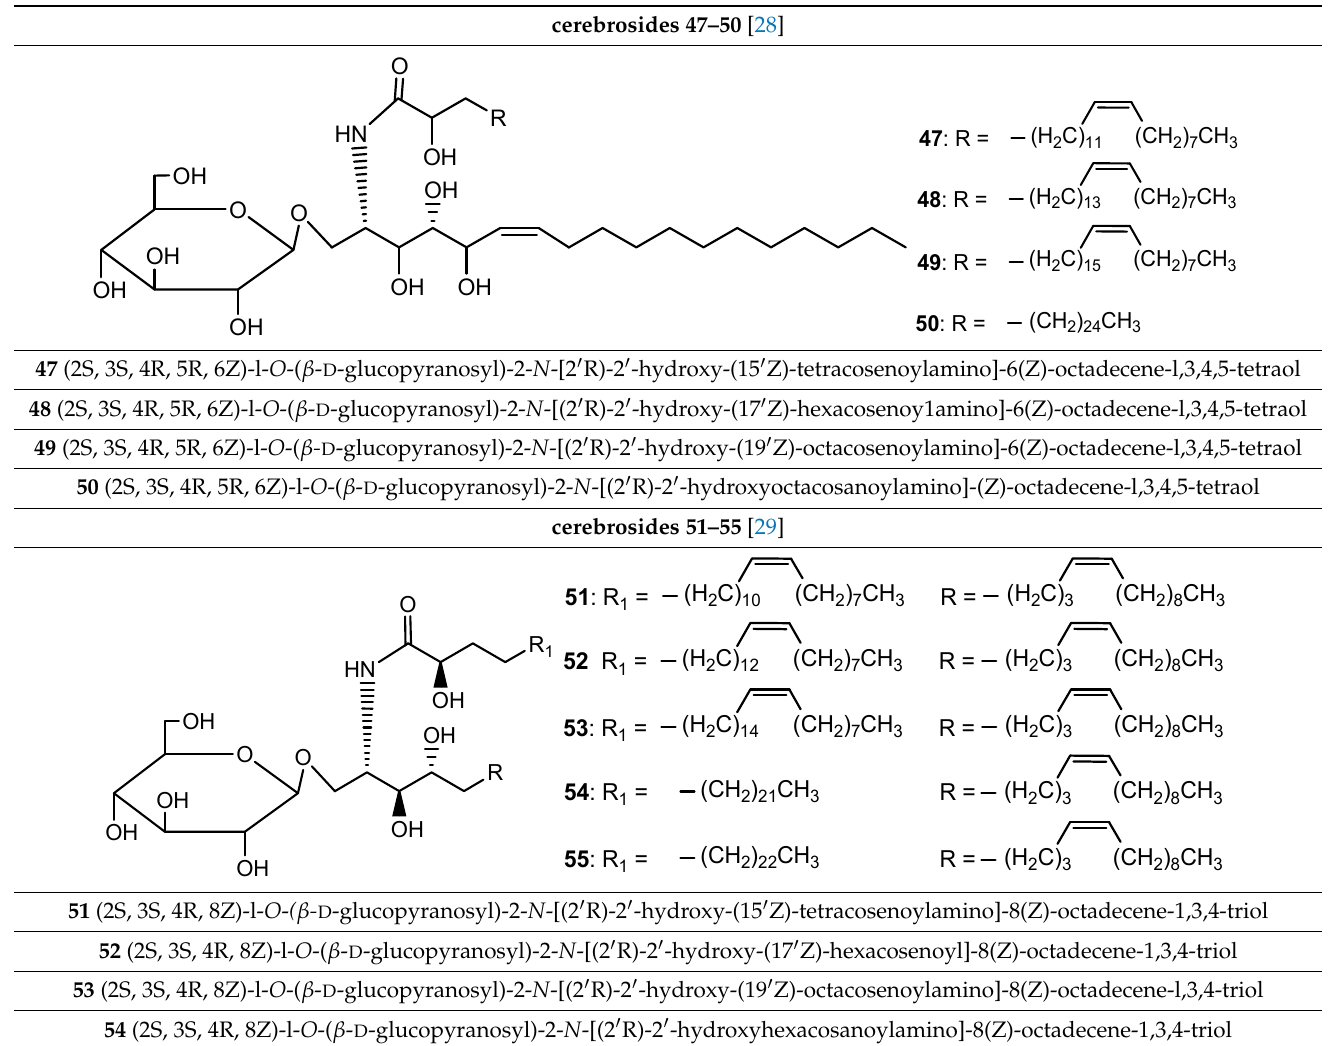
Table 3. Cerebrosides identified from the latex of E. characias (compounds 47 – 55 ).